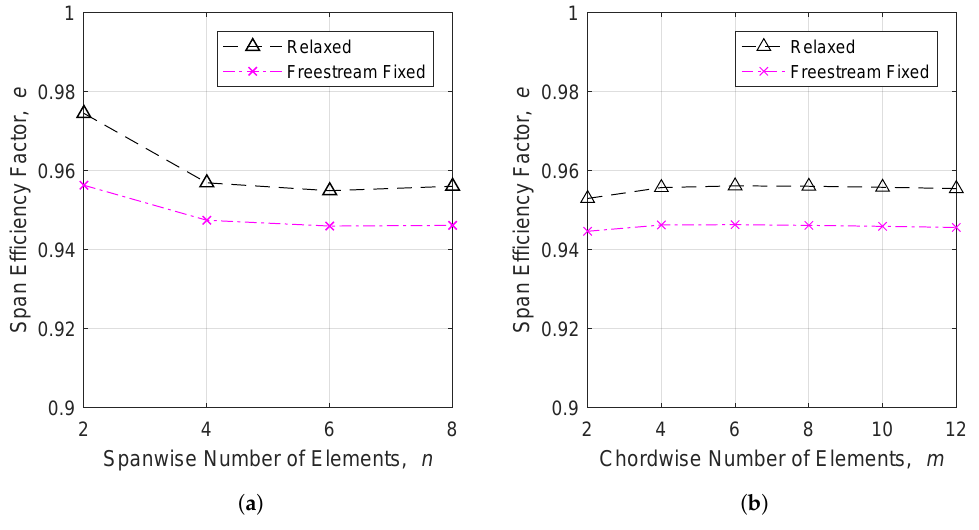
Figure 5. Convergence of the span efficiency factor as the number of elements is increased for a rectangular wing. ( a ) Varying number of spanwise elements, m = 8; ( b ) varying number of chordwise elements, n =